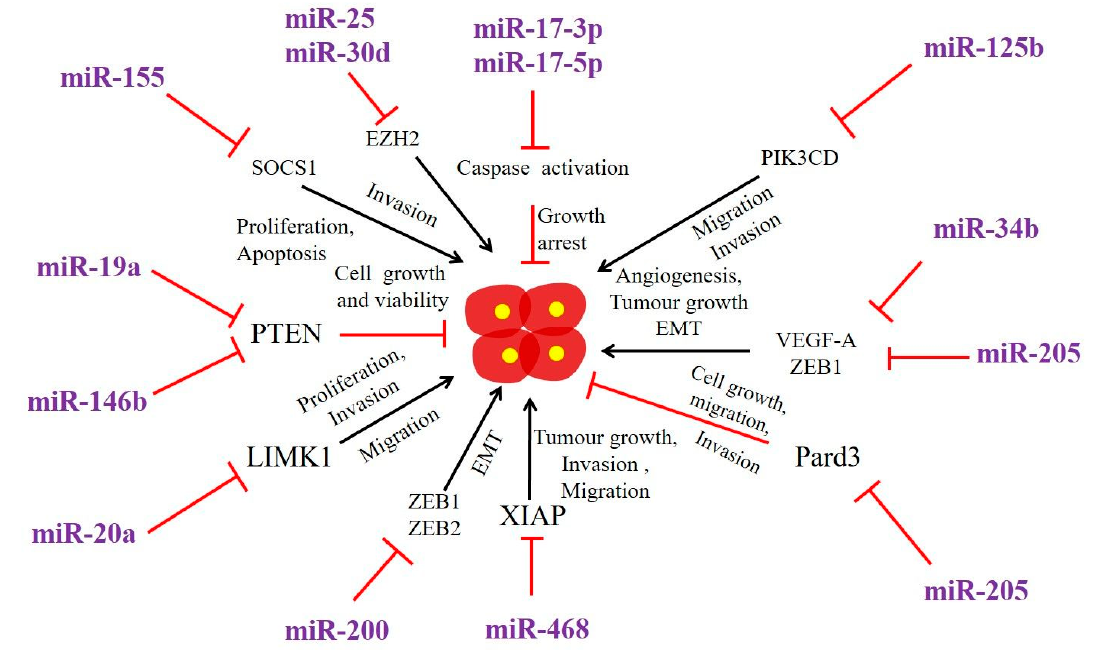
Figure 2. Role of miRNAs in the regulation of gene expression in anaplastic thyroid carcinoma (ATC) . miRNAs upregulate or downregulate the genes related to development, progression, invasion migration, and therapy resistance in ATC. PTEN: Phosphatase and tensin homolog; XIAP: X-linked inhibitor of apoptosis protein; SOCS1: Suppressor of Cytokine Signaling 1; PIK3CD: Phosphoinositide 3-kinase catalytic subunit delta.